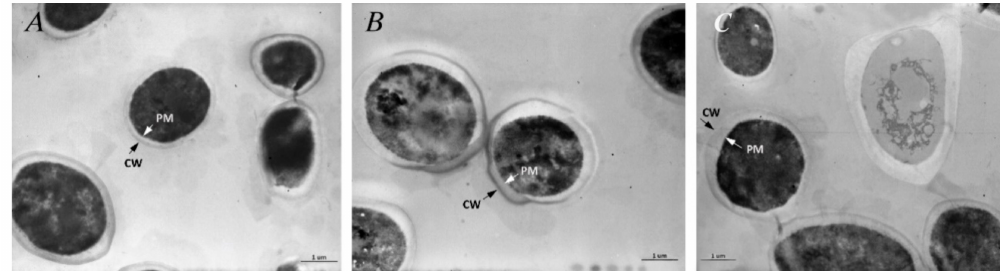
Figure 6. ( A ) After contact with liposomes, the cells show quite conserved morphology in comparison to the control, while ( B ) after contact with glycerosomes and ( C ) PG-PEVs, halos of di ff erent thicknesses delimiting and infiltrating the CW are common features in the cells, with some occasional aspects of cell degeneration using